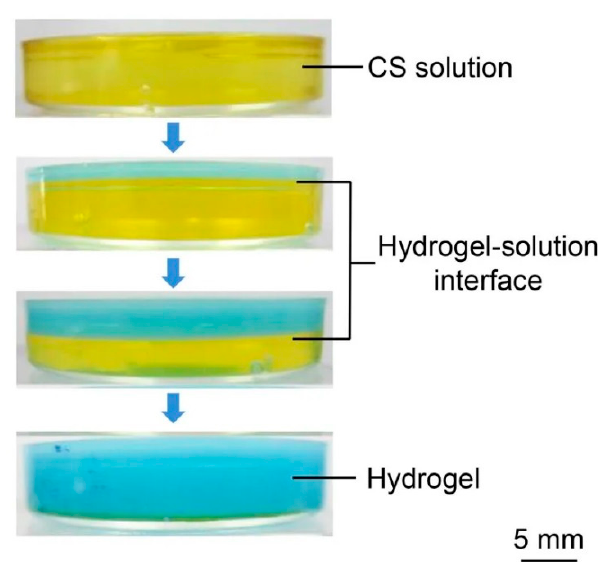
Figure 6. Preparation of chitosan hydrogel by a single opening mold. Digital photographs of gelation process at different reaction time. Solution and hydrogel were colored by bromothmol blue for visibility. In view of pH range, the blue part corresponded to hydrogel already formed while the bellow part corresponded to unreacted solution and the boundary indicated the hydrogel-solution interface. Reprinted from [20] with permission.